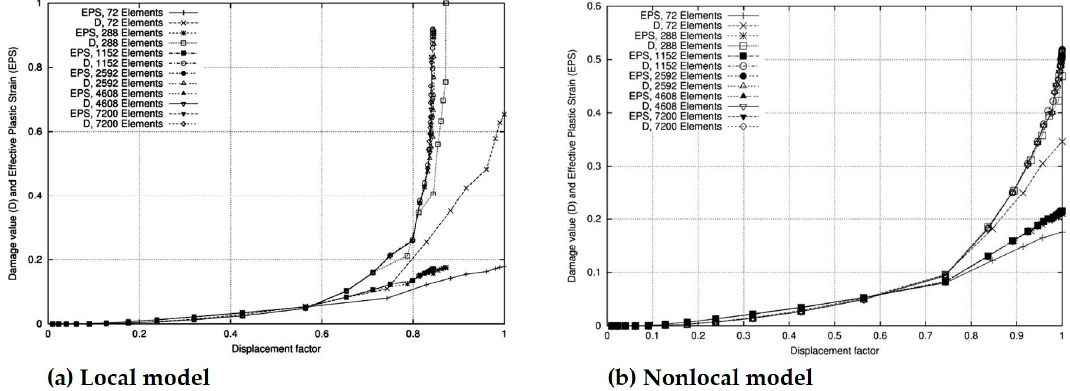
Figure 2. Effect of local and nonlocal models on mesh size dependency [33].